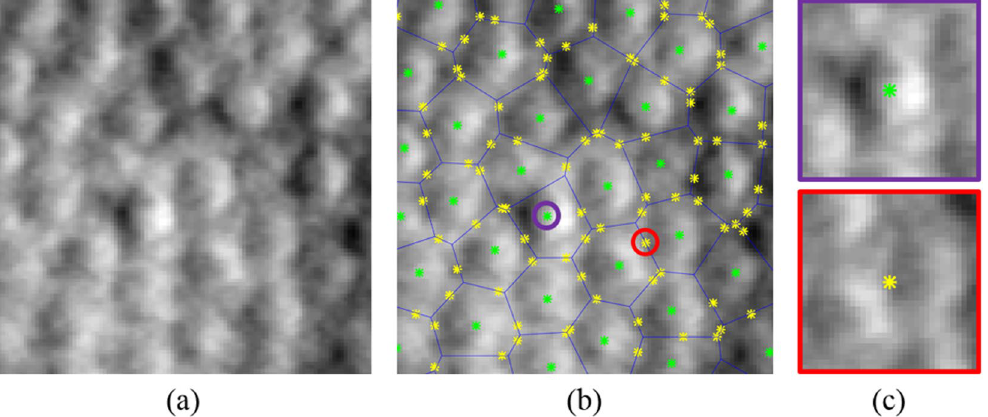
Figure 3. Extraction of labeled patches from cone images. ( a ) Original cropped split detector AOSLO image. ( b ) Image ( a ) with Voronoi diagram overlain in blue. Manually marked cones are shown in green and randomly generated locations along Voronoi edges in yellow. ( c ) Example cone (top-purple) and non-cone (bottom-red) patches (size 33 × 33 pixels) from positions circled in ( b ) with center